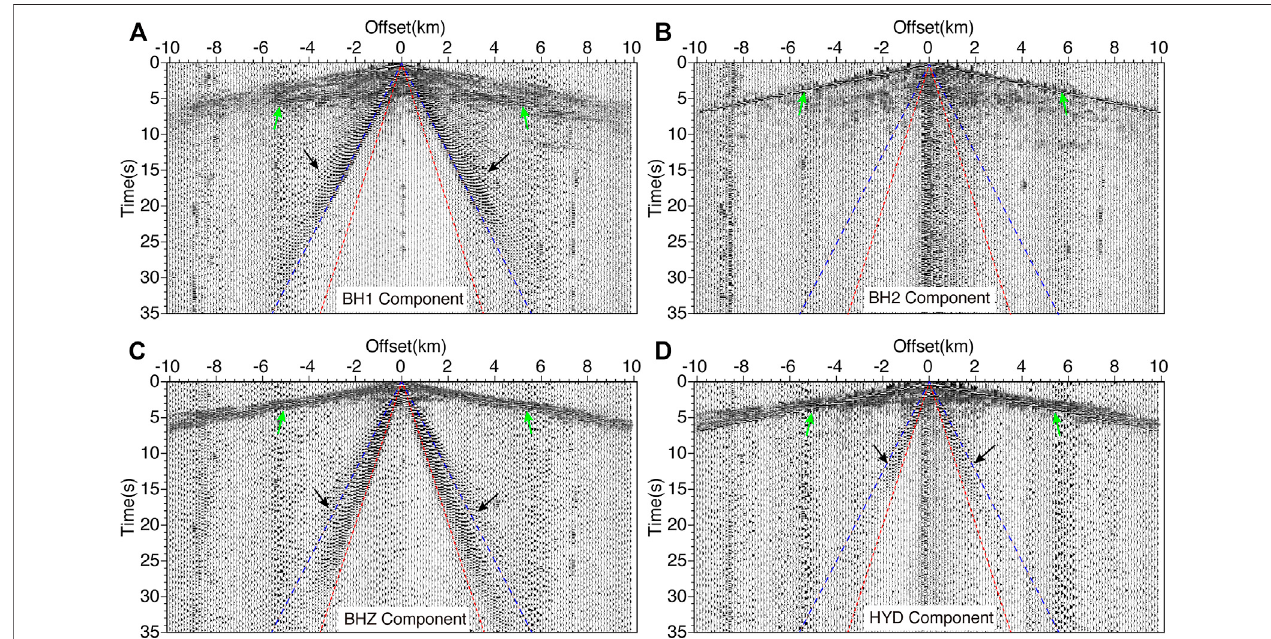
FIGURE2| Pre-processedcommonreceivergathers(CRGs)recordedatOBSstationC22.Panels (A,B) showtwohorizontalseismiccomponentswithdeployed random azimuths. Panels (C, D) show the CRGs of the vertical and hydrophone components, respectively. The red and blue dashed lines denote apparent velocities of 100 and 160 m/s, respectively. The pre-processing involved tracenormalization using the mean with bandpass fi ltering at 0.5 – 6.3 Hz, and fi nally Wiener (least-squares) predictive error fi ltering. The green and black arrows denote the body and Scholte waves, respectively.